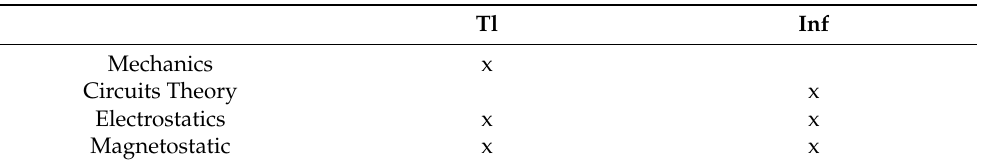
Table 2. Contents of every course involved in the experiment. Contents are grouped according to the degree of the courses: Telecommunications (Tl) or Informatics (Inf). An x in a cell indicates that the related content is covered in this course.